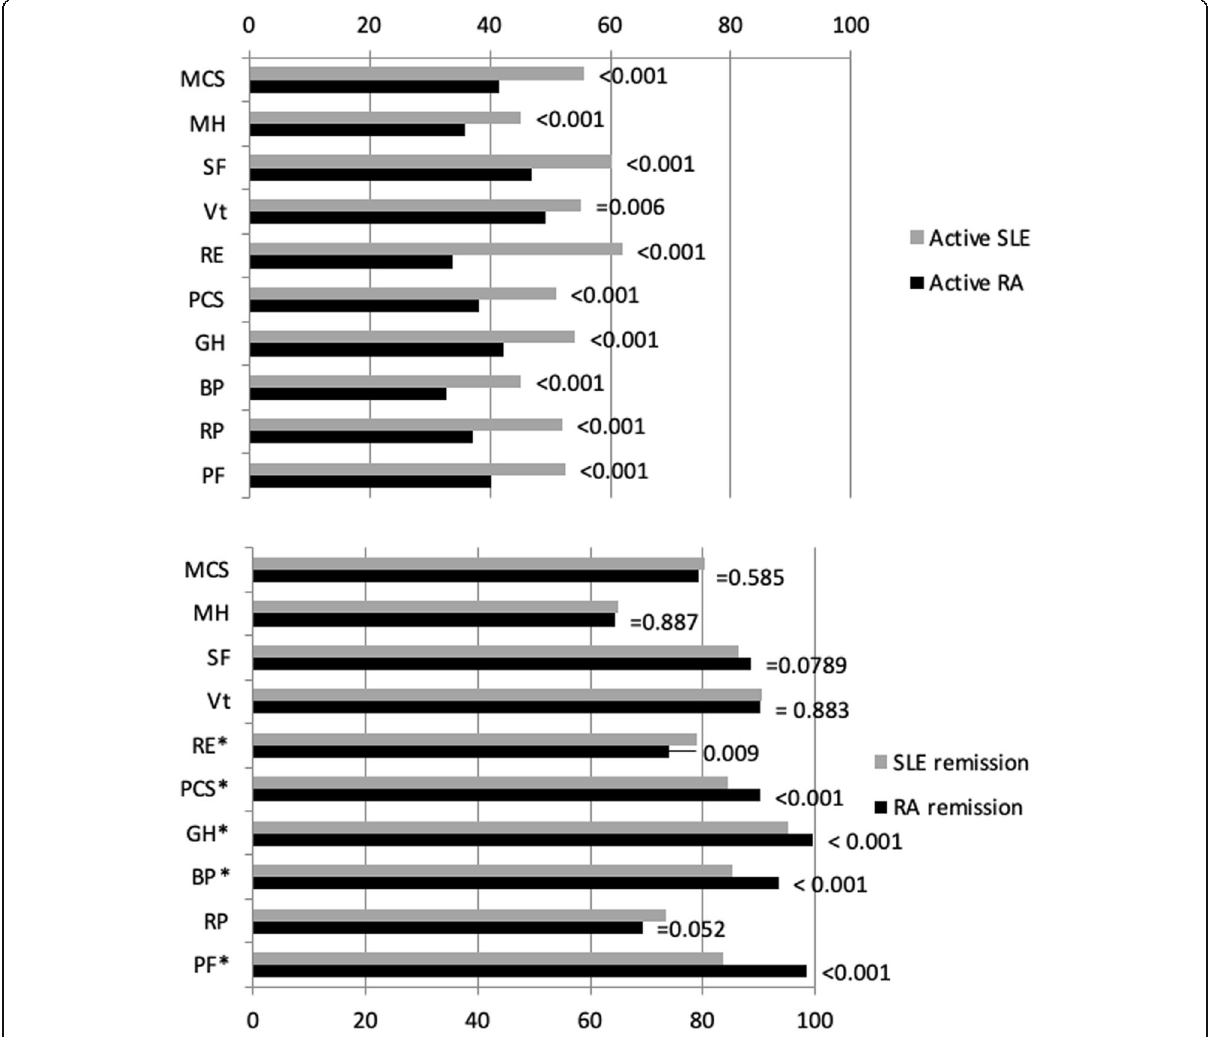
Fig. 2 SF-36 in 62 RA and 34 SLE female patients during active disease and after sustained remission achieved